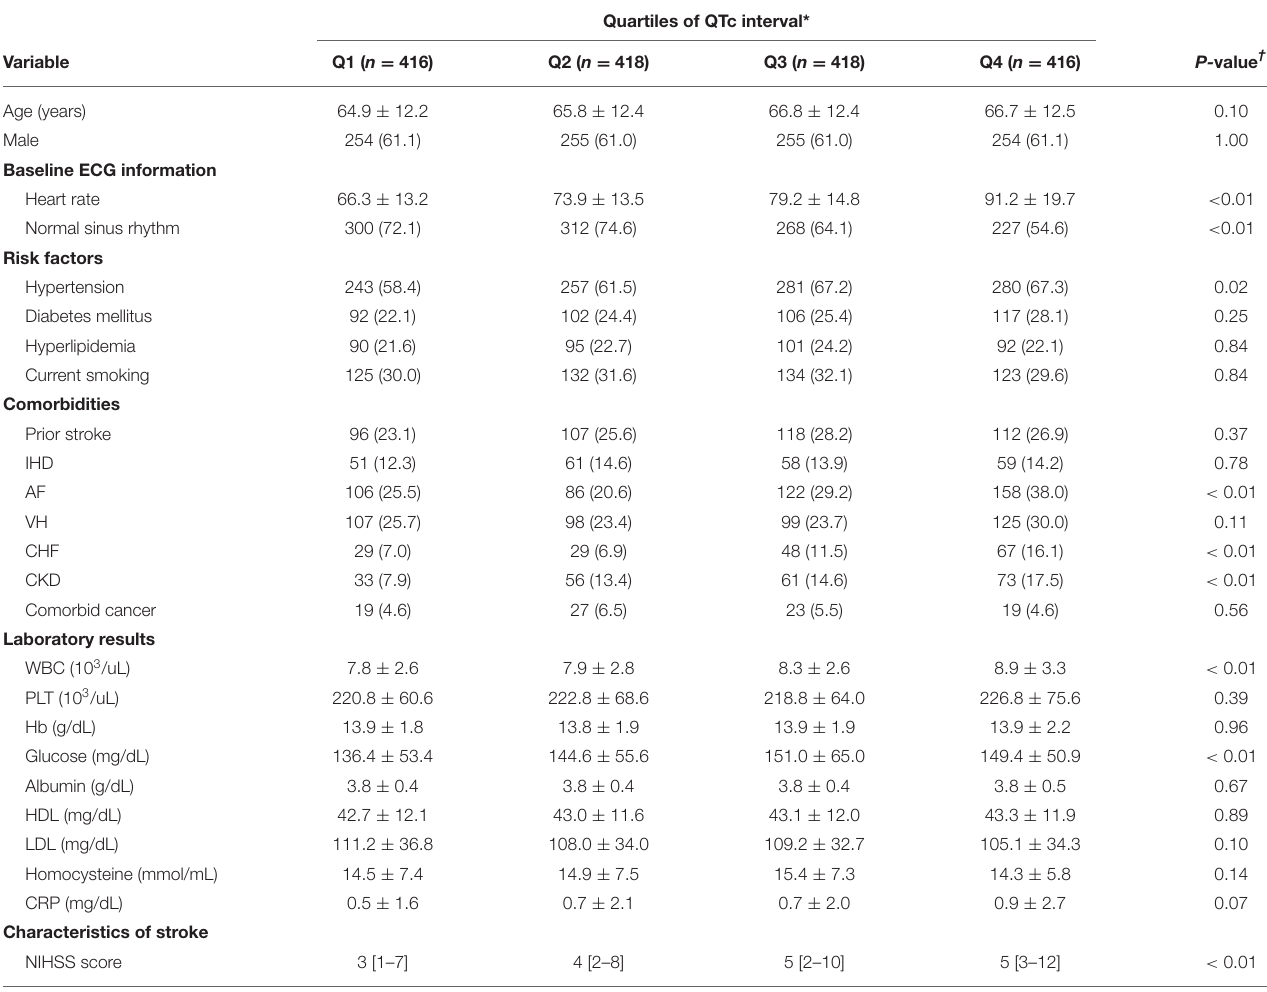
TABLE 1 | Characteristics according to the corrected QT (QTc)